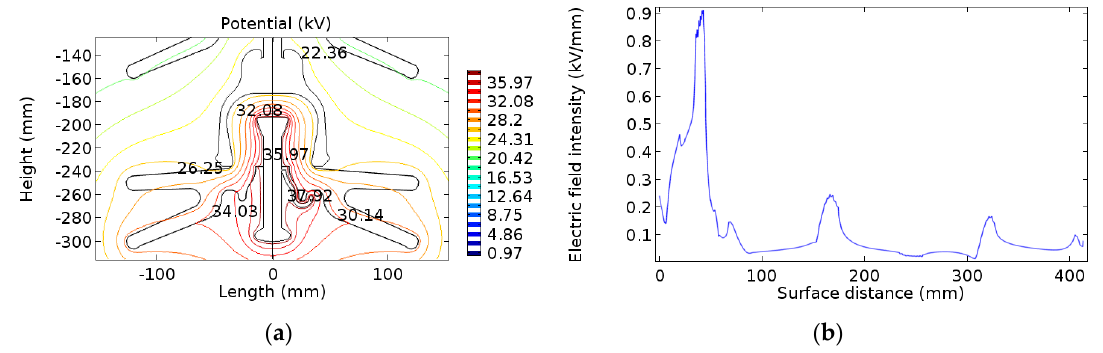
Figure 17. Simulation results of Extension 2: ( a ) equipotential line distribution; ( b ) electric field distribution along No. 1 insulator.